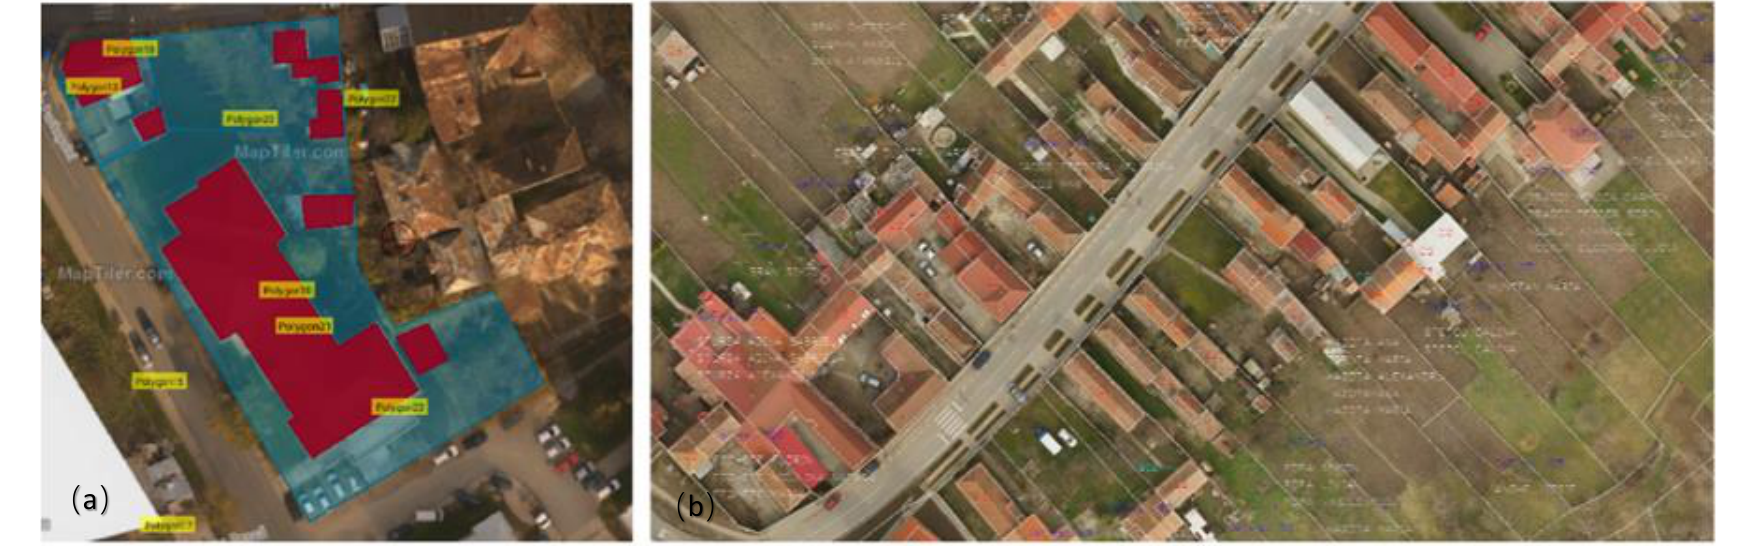
Figure 14. Crowdsourced cadastral data. ( a ) Caracal city center and ( b ) Ciugud village build-up